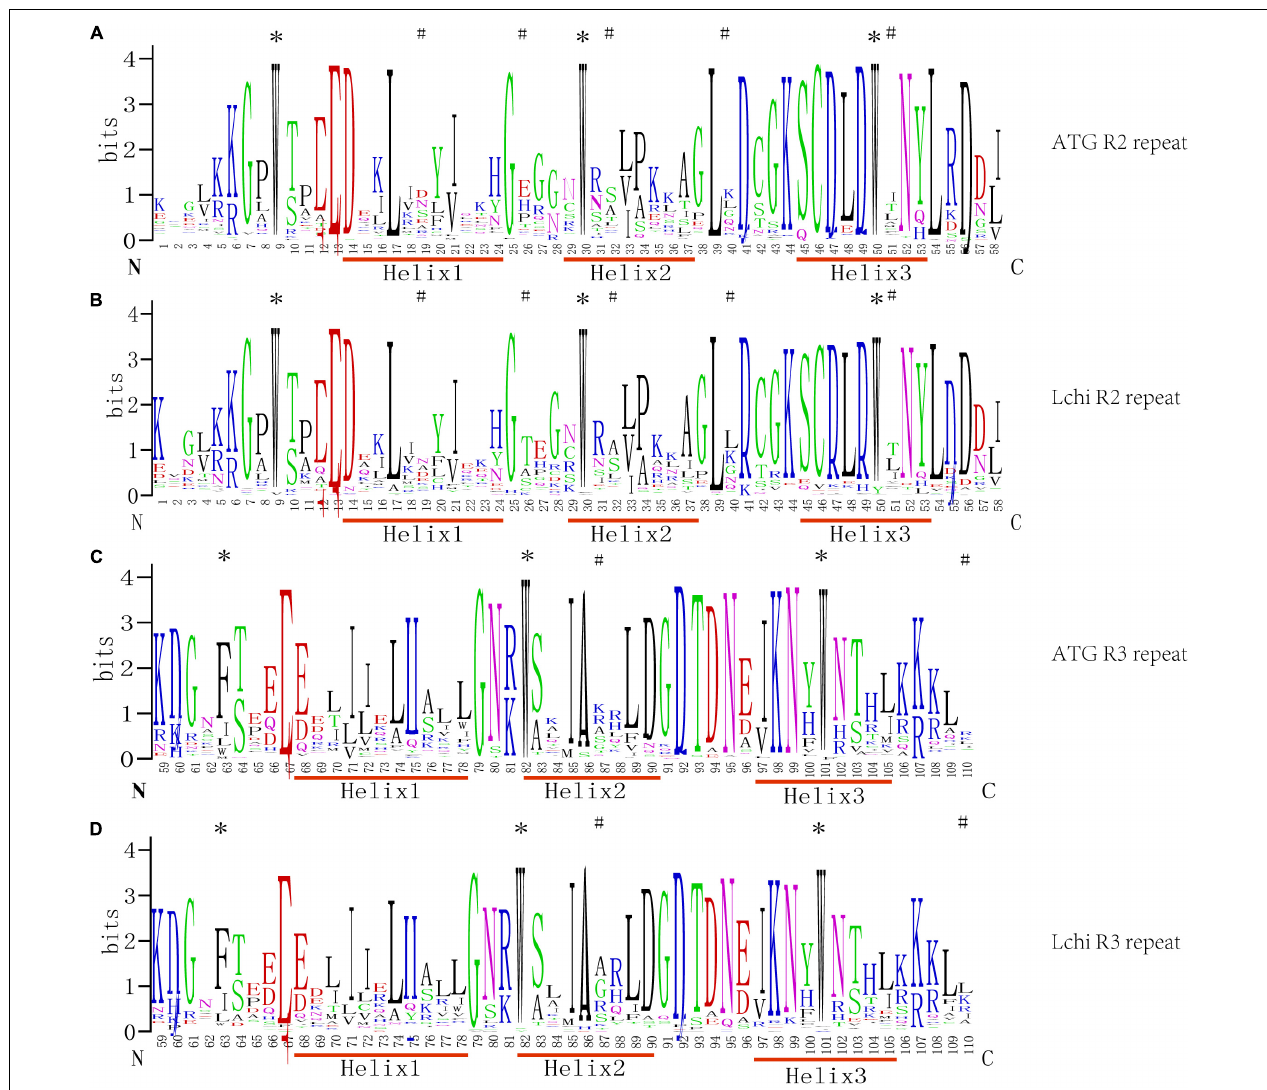
FIGURE 1 | Sequence logos of the R2 and R3MYB repeats from Liriodendron chinense ( Lchi ) and Arabidopsis . Multiple sequence alignment analysis of 76 Lchi and 126 Arabidopsis R2R3-MYB domains was used in ClustalX2.1. Panels (A,B) were the R2 repeats, and panels (C,D) were the R3 repeats in Arabidopsis and Lchi . N and C represent the N-terminal and C-terminal, respectively, and the bit score shows the conservative information for all positions in the sequence; the higher the value, the higher the conservation, and the different colors were generated by the website randomly. The asterisks represent the highly conserved tryptophan (W) and phenylalanine (F) residues, and the # represents the different patterns of positions between Lchi and Arabidopsis .